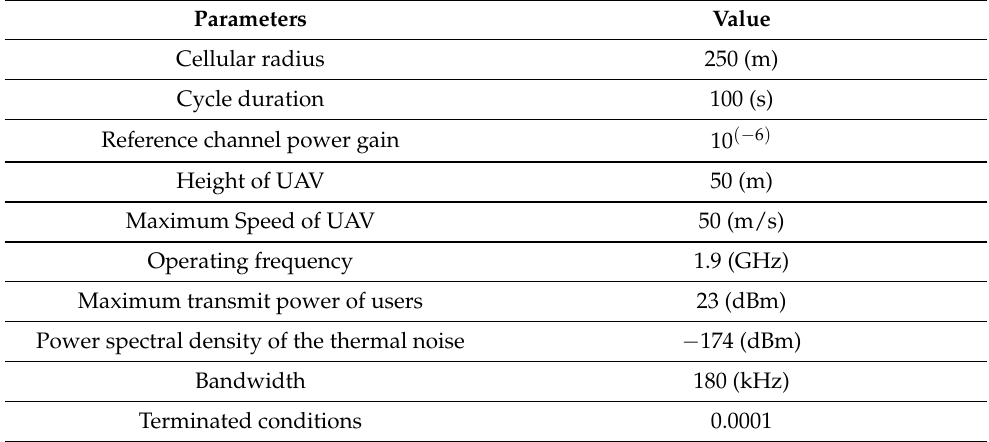
Table 2. Simulated network